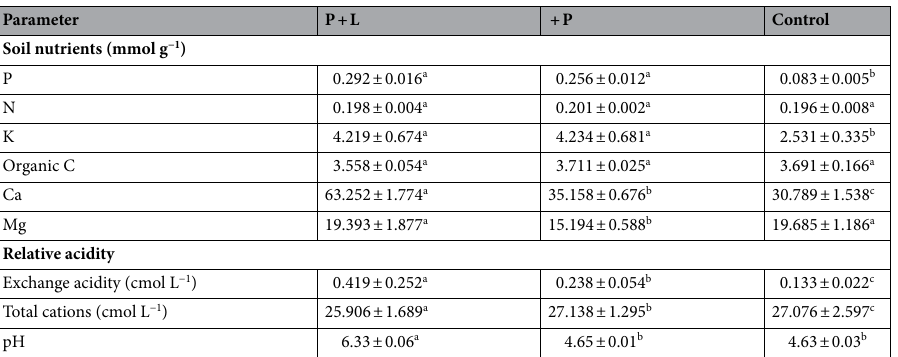
Table 1. Soil nutrients concentrations, total cations, exchange acidity and pH in soils supplemented with phosphorus and lime, soils rich in phosphorus and control soils collected at Ukulinga farm, KwaZulu-Natal. Values are expressed as means ± SE, n = 5. In each row, different letters represent significant differences based on Tukey’s Post Hoc statistical analysis. (*p <